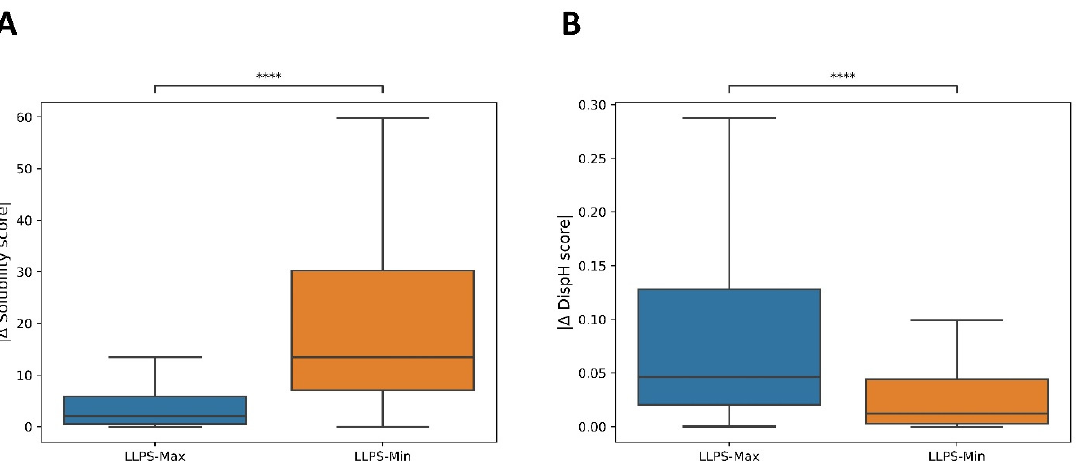
Figure 1. 10% maximum ( A ) and 10% minimum ( B ) solubility distribution of LLPS-DRs in the range between pH 4 and 9 using step size 0.1. Maximum solubility is mostly attained around neutral pH ( μ = 6.95), whereas minimum solubilities are found at the extremes of the pH interval, in more acidic or basic conditions.